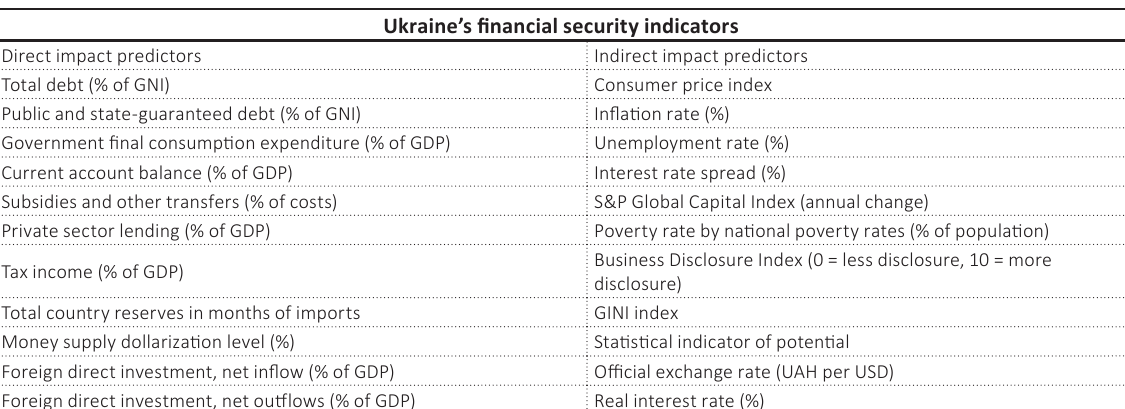
Table 2. Input indicators for the model for assessing Ukraine’s financial security by influencing